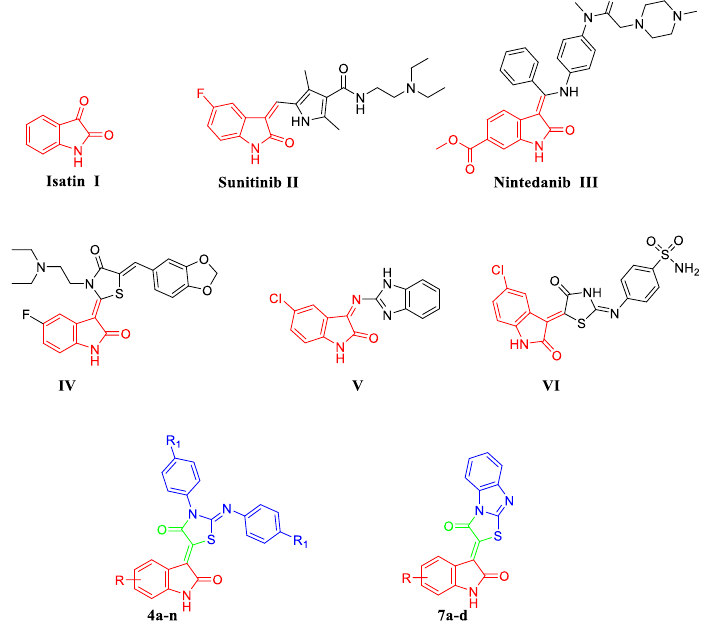
Figure 1. Structures of isatin-based approved anticancer drugs ( II & III ), some reported isatin-based hybrids with potent antiproliferative activity against breast cancer ( VII – IX ), and the target conjugates ( 4a – n and 7a – d ).